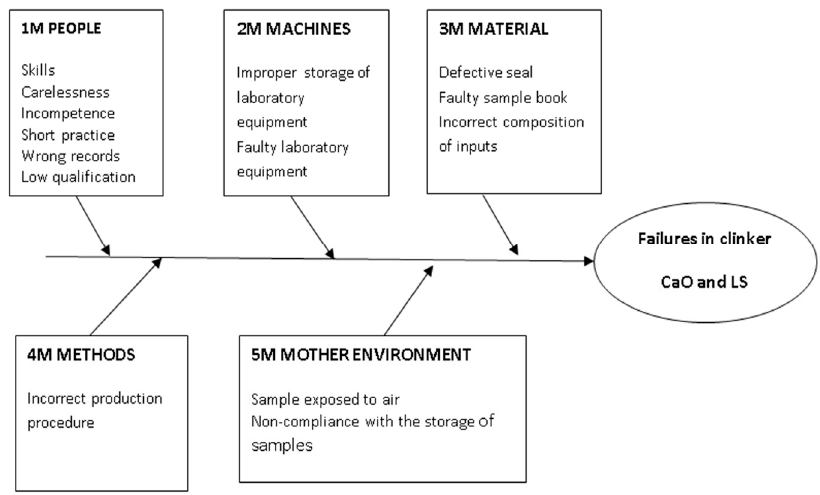
Figure 10. Ishikawa diagram for failures in clinker. Source: own source.